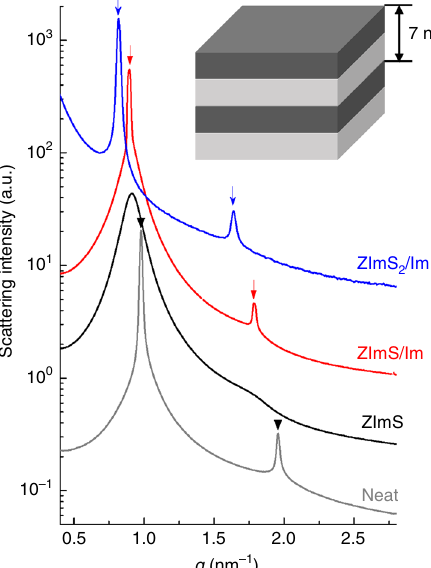
Fig. 3 Effects of additives on self-assembly of PSS:Im- b -PMB. SAXS pro fi les of PSS:Im- b -PMB comprising various additives, measured at 25 °C. Bragg peaks at 1 q *, 2 q * ( q * = 2 π / d 100 ) indicate lamellar morphology with ca. 7 nm domain size, as schematically depicted in the